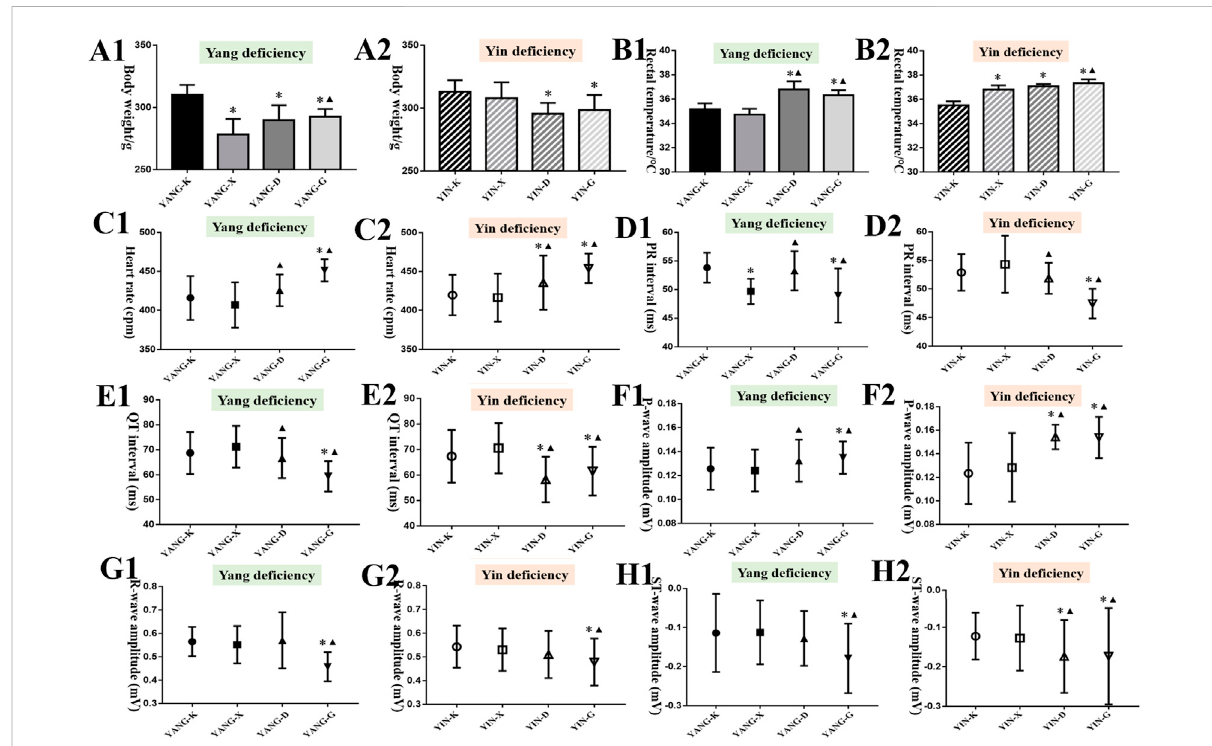
FIGURE 5 ResultsofgeneralstatusandECGofratsindifferentgroups(14 d).Note:Comparedwiththecorrespondingcontrolgroup,* p < 0.05;compared with the corresponding model group, ▲ p < 0.05. (A) Body weight; (B) rectal temperature; (C) heart rate; (D) PR interval; (E) QT interval; (F) P-wave amplitude; (G) R-wave amplitude; (H) ST-wave